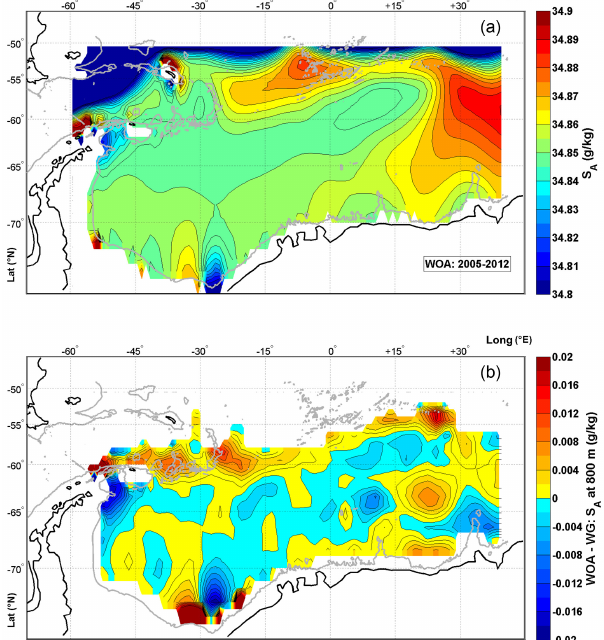
Figure 26. Conservative temperature ( ◦ C) at 800m from the global WOCE climatology during 1900 to 2000. (i.e. WOCE_global in Fig. 23). Panel (b) shows the difference with the entire time span of the data set provided, i.e. WOCE_global minus WG_all. The grey contour shows the 2000m